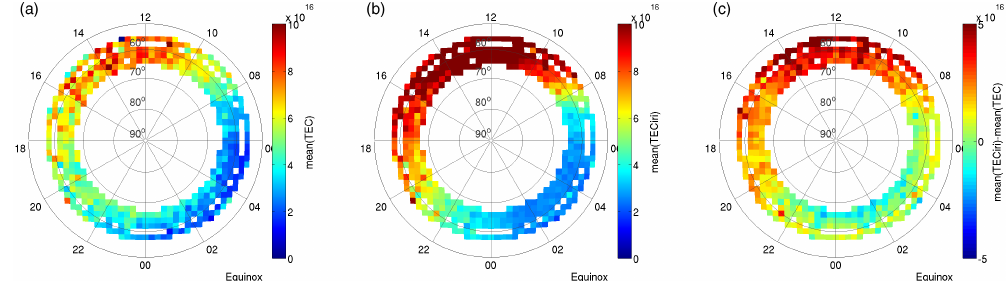
Figure 7. Magnetic local time mean values for equinox time tomographic VTEC, corresponding IRI-2012 values and the difference between the two.